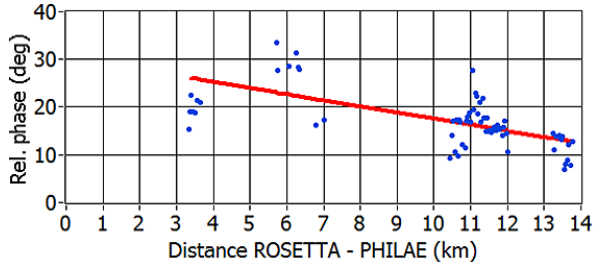
Figure 11. The phase shift between signals of RPCMAG and ROMAP (blue), taken at the frequency at which the maximum cross-spectral density occurs, versus the orbiter-lander distance. The red line represents the linear